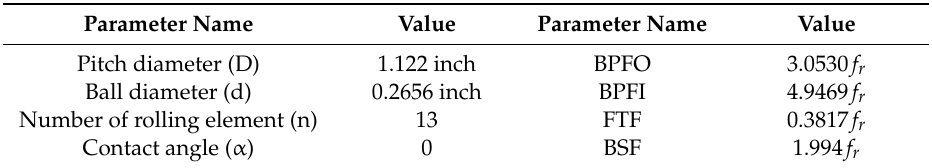
Table 4. Bearing information.